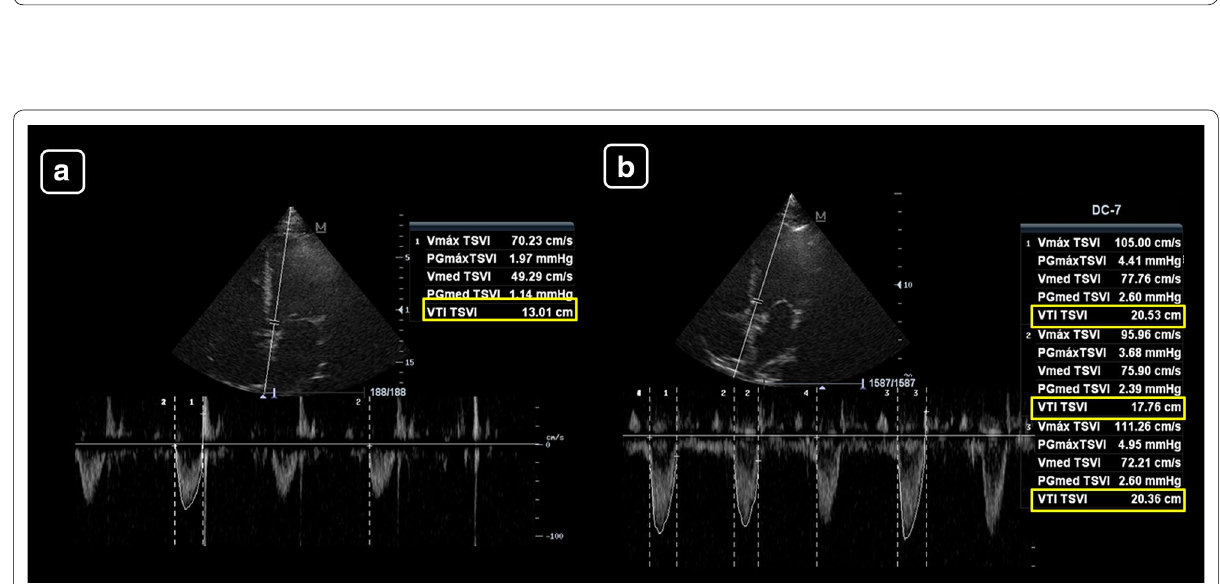
Fig. 4 Left ventricular tract velocity–time integral (LVOT VTI, yellow boxes) for assessing changes in the SV with treatments, in a patient with suspicion of hypovolemia. a Baseline. b After a fluid challenge. A > 15% increase in the VTI indicates a positive response to therapy, as seen in this